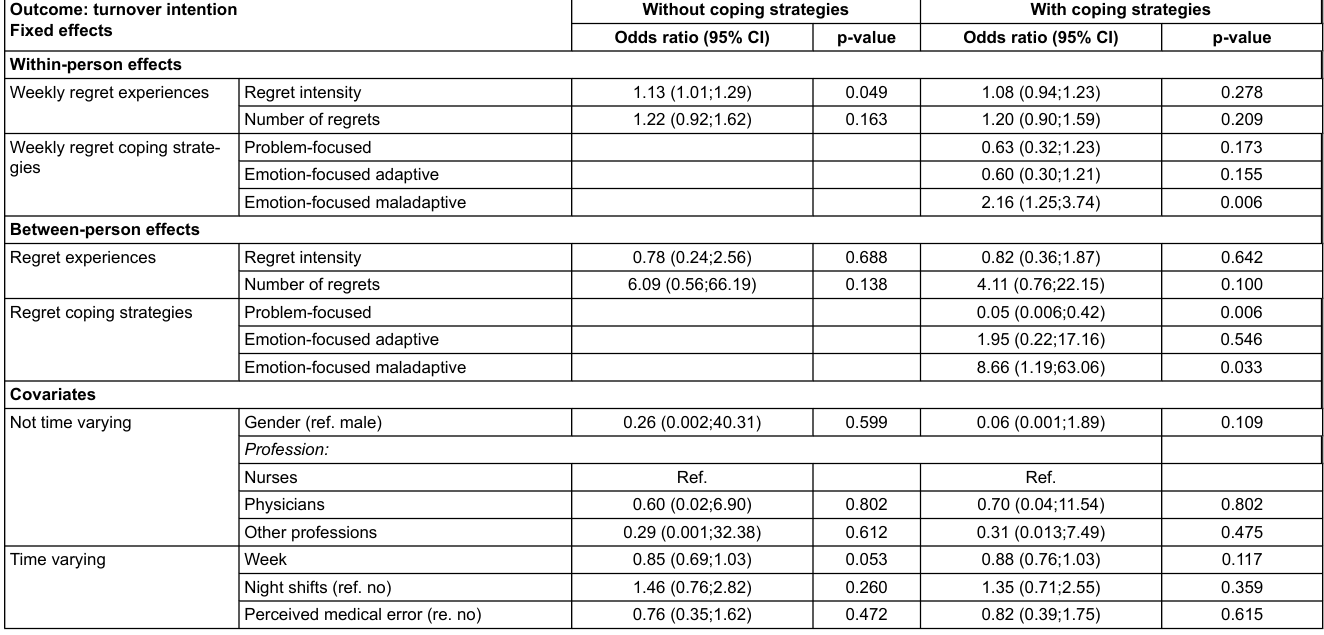
Table 3: Linear mixed models testing the association of within- and between-person variability in care-related regrets as predictors of job satisfaction and the mediation of cop- ing strategies. Outcome: turnover intention Fixed